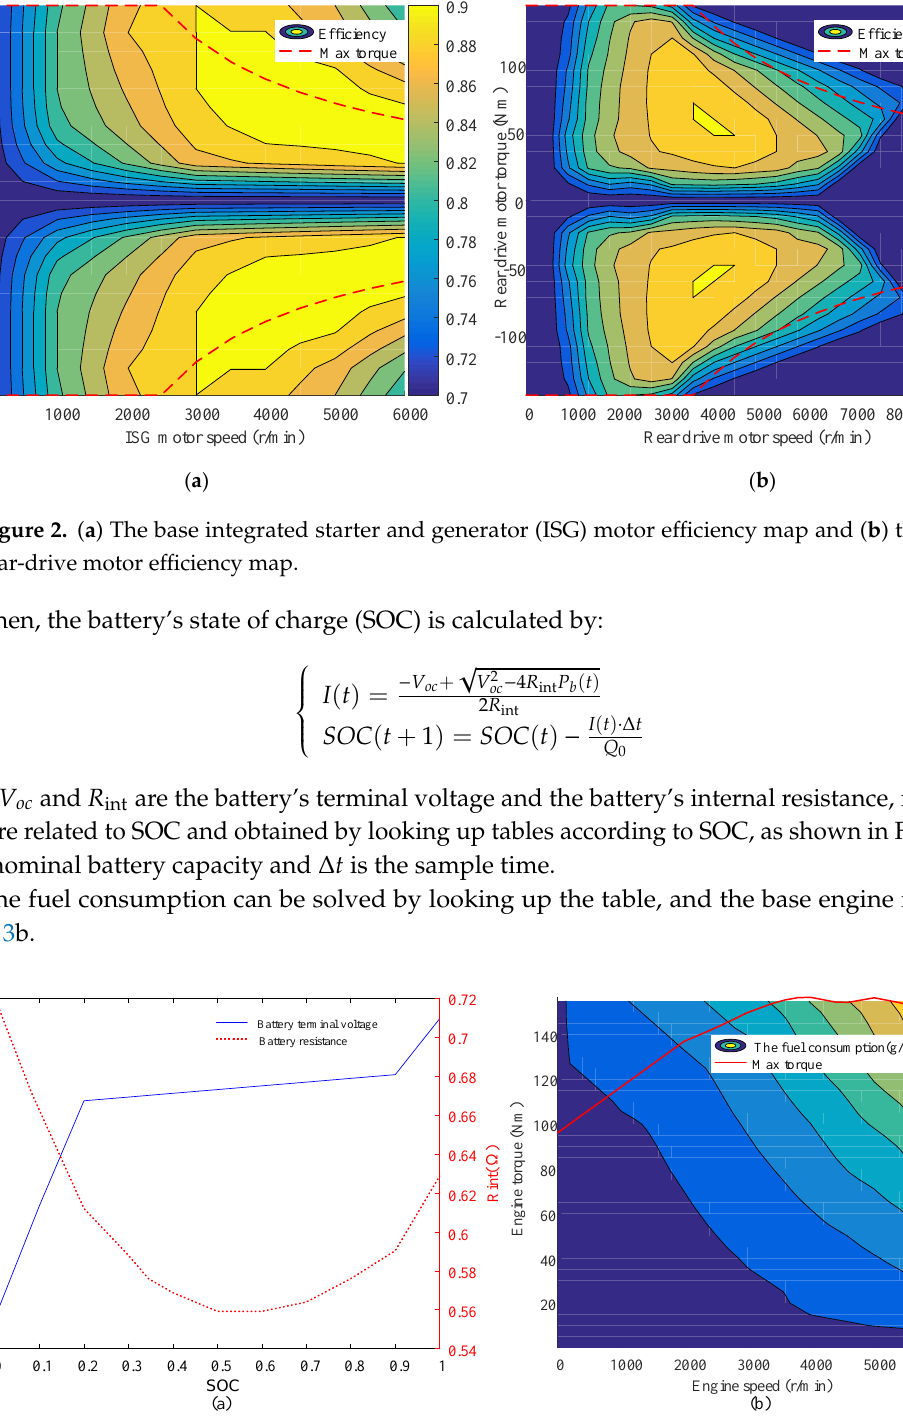
Figure 3. ( a ) The battery’s terminal voltage and internal resistance and ( b ) the engine’s fuel consumption.